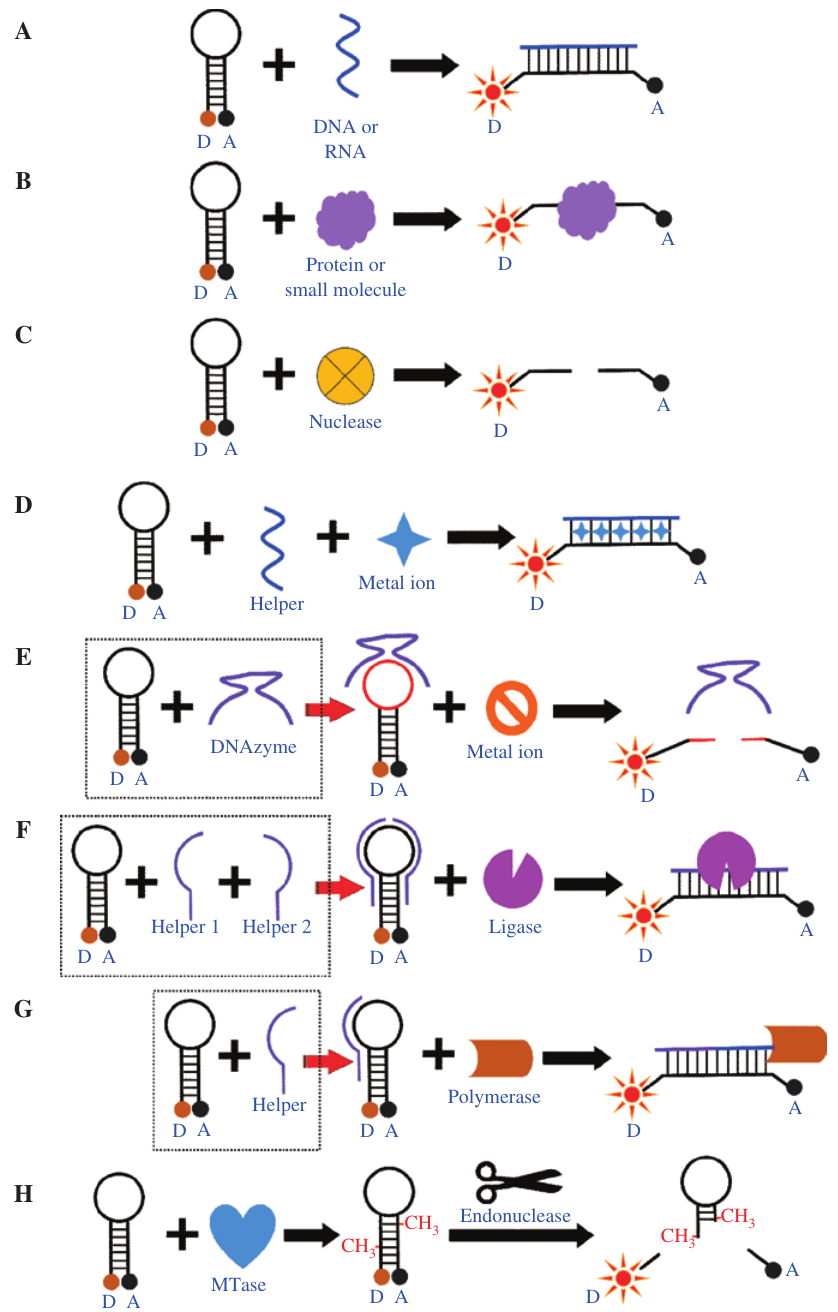
Figure 3: Basic principles of MB-based homogeneous sensing systems (open-to-signal). Determination of nucleic acids (A), proteins or small molecules (B), nucleases (C), metal ions (D) and (E), ligases (F), polymerases (G), and MTases